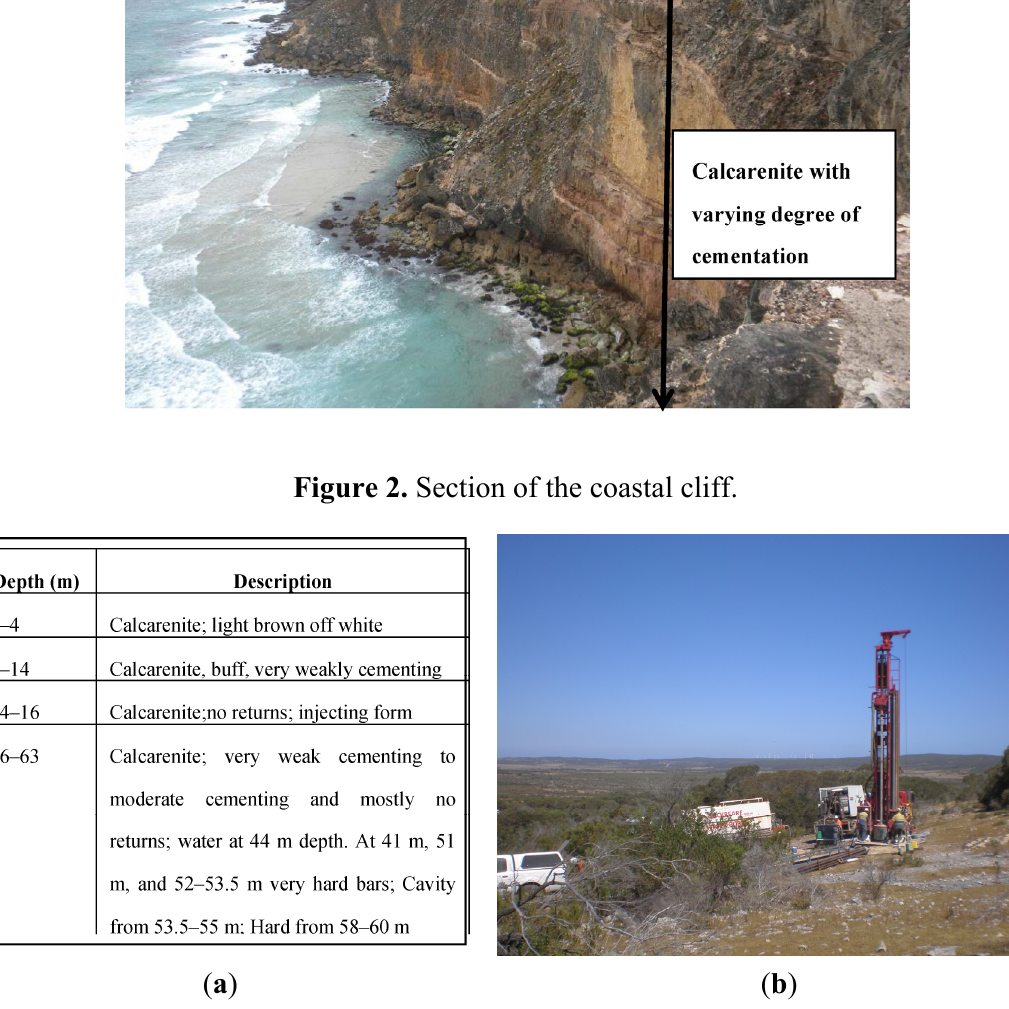
Figure 3. Geology and topographic features at Site 1 ( a ) Summary of lithological description ( b ) Drilling at Site 1 (note the surface calcrete in foreground and coastal dunes with vegetation cover in the